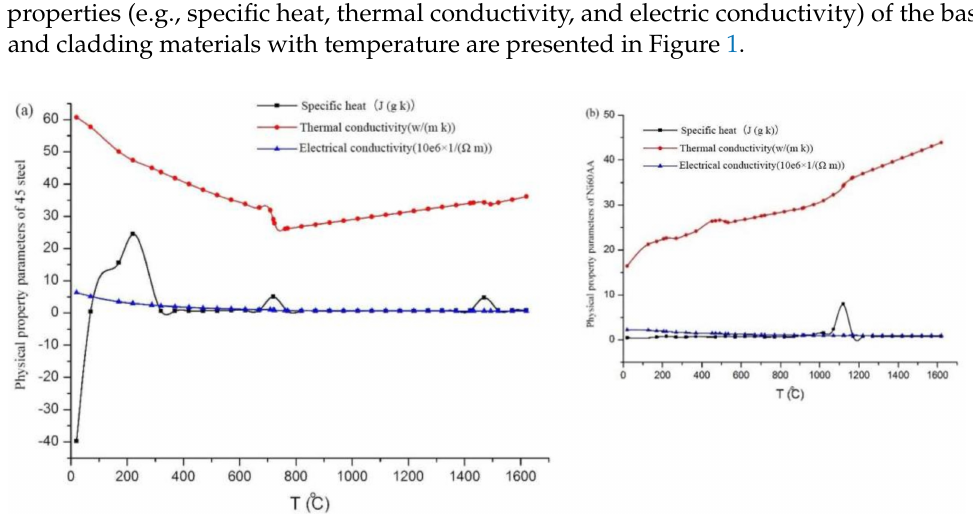
Figure 1. Changes in thermophysical properties with temperature: ( a ) AISI 1045 steel; ( b )